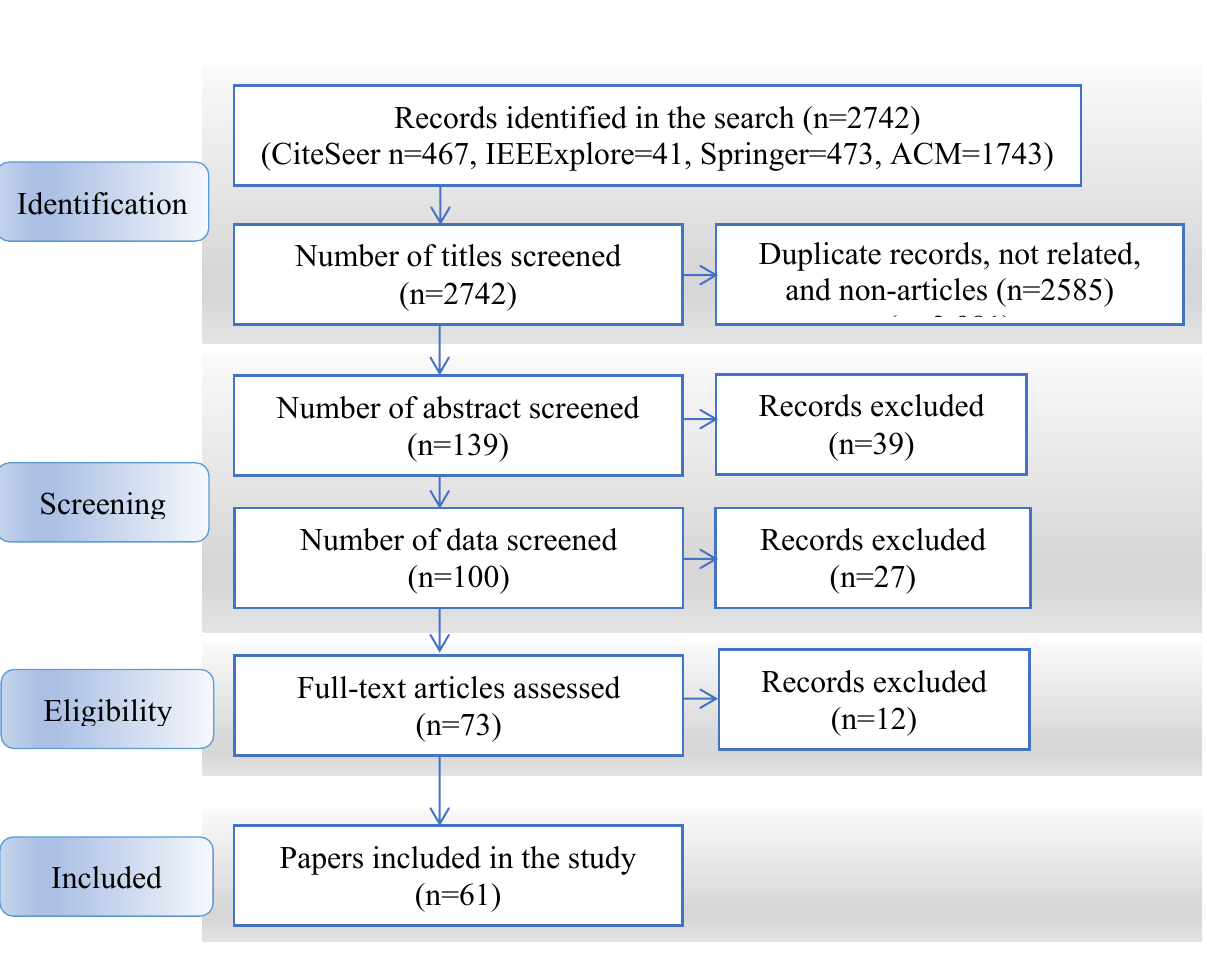
Figure 1. Flowchart of the steps used in the literature